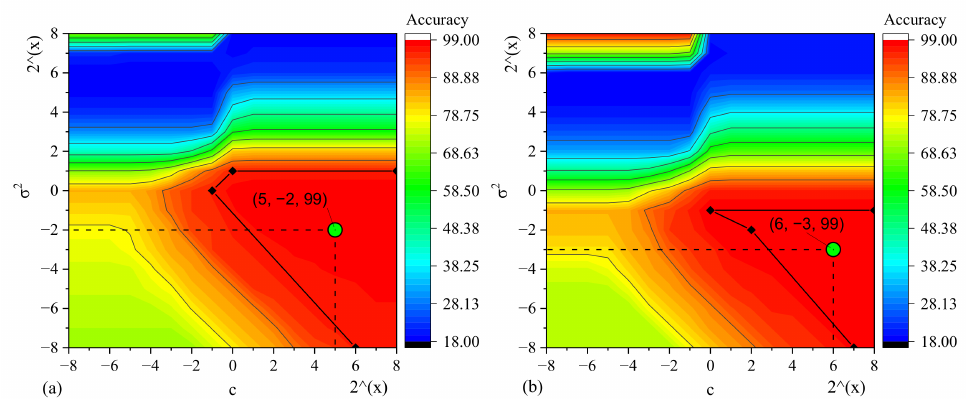
Figure 14. The fault diagnosis accuracies of PMDCMs by utilizing the SVM classifier with different hyperparameters, ( a ) with the 136 selected features by the VTFS method, ( b ) with the 238 selected features by the GVFS